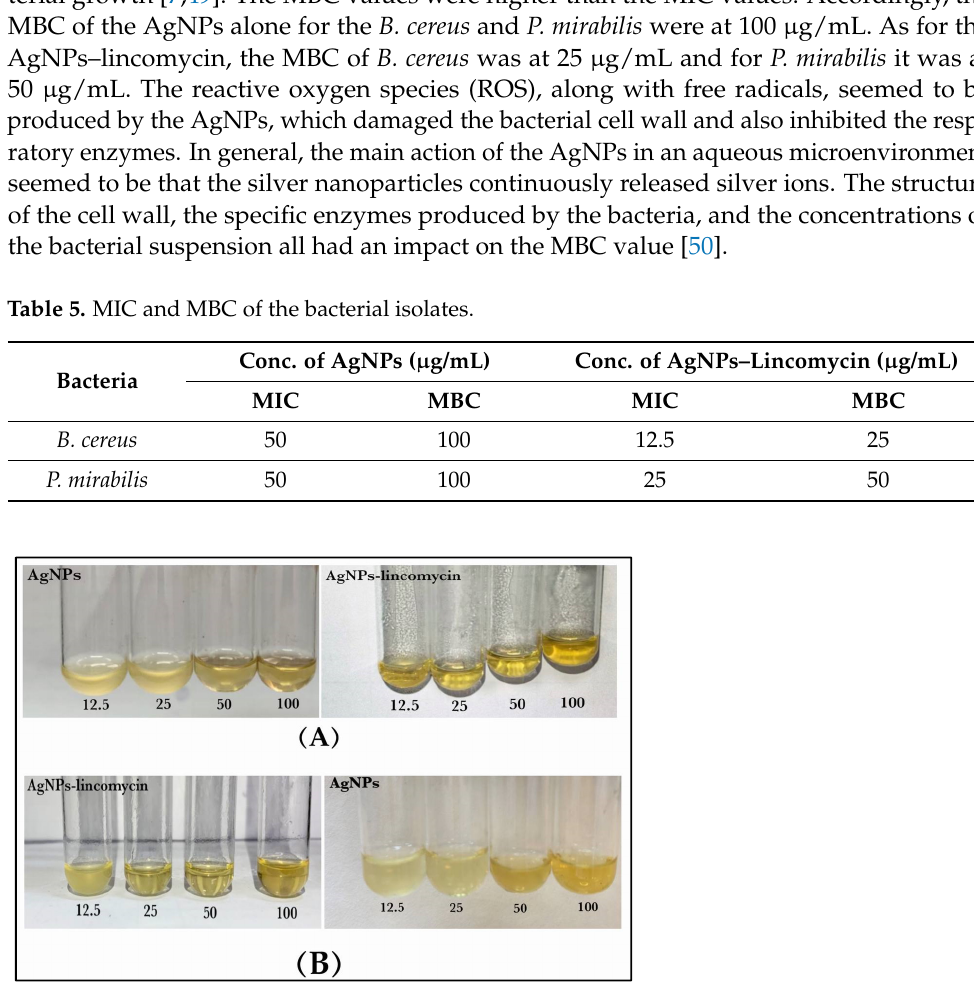
Figure 12. MIC and MBC of the AgNPs and AgNPs–lincomycin against bacterial isolate: ( A ) B. cereus and ( B ) P. mirabilis .